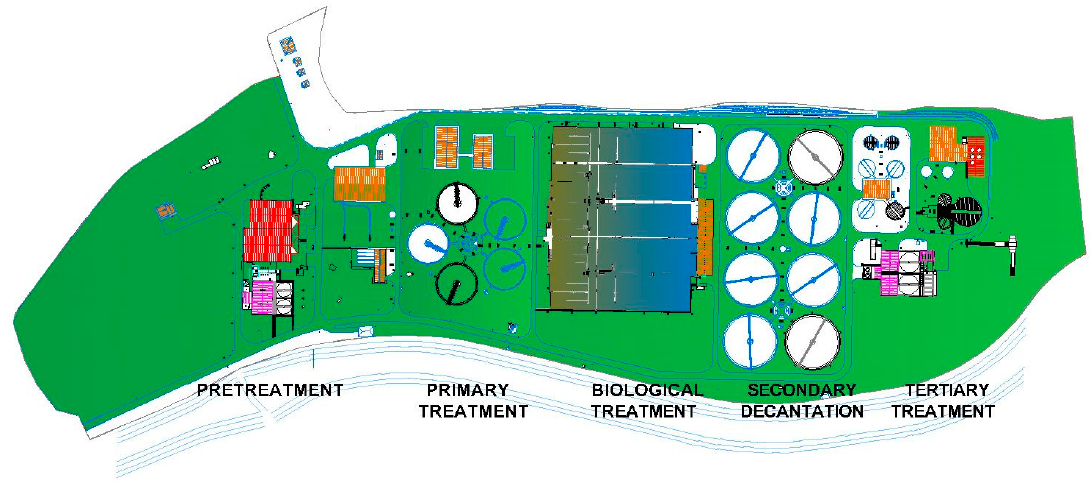
Figure 1. Plan view of the Villapérez wastewater treatment plant (WWTP) (Asturias, Spain). The pre-treatment has the capacity to treat an inflow of 8.5 m 3 /s and starts with two, thick wells, equipped with a 500 L clamshell bucket. The plant then has four roughing channels, each of which includes an automatic cleaning screen with a 60 mm clearance and a self-cleaning fines screen with a 3 mm clearance and an inclination of 50°. After the